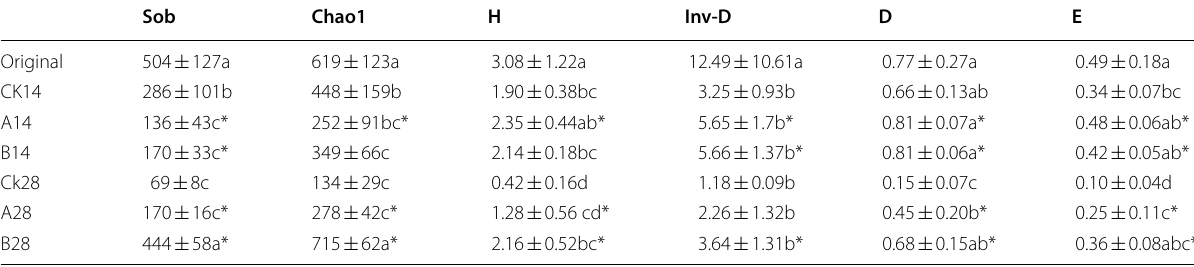
Results are means and SD of replicates (n 8) = Statistically significant differences ( p < 0.05) in values between treatments are indicated through different letters The ‘*’ indicates the difference between treatment A or B and control (at the same day) is significant at p < 0.05 level as assessed by student t -test